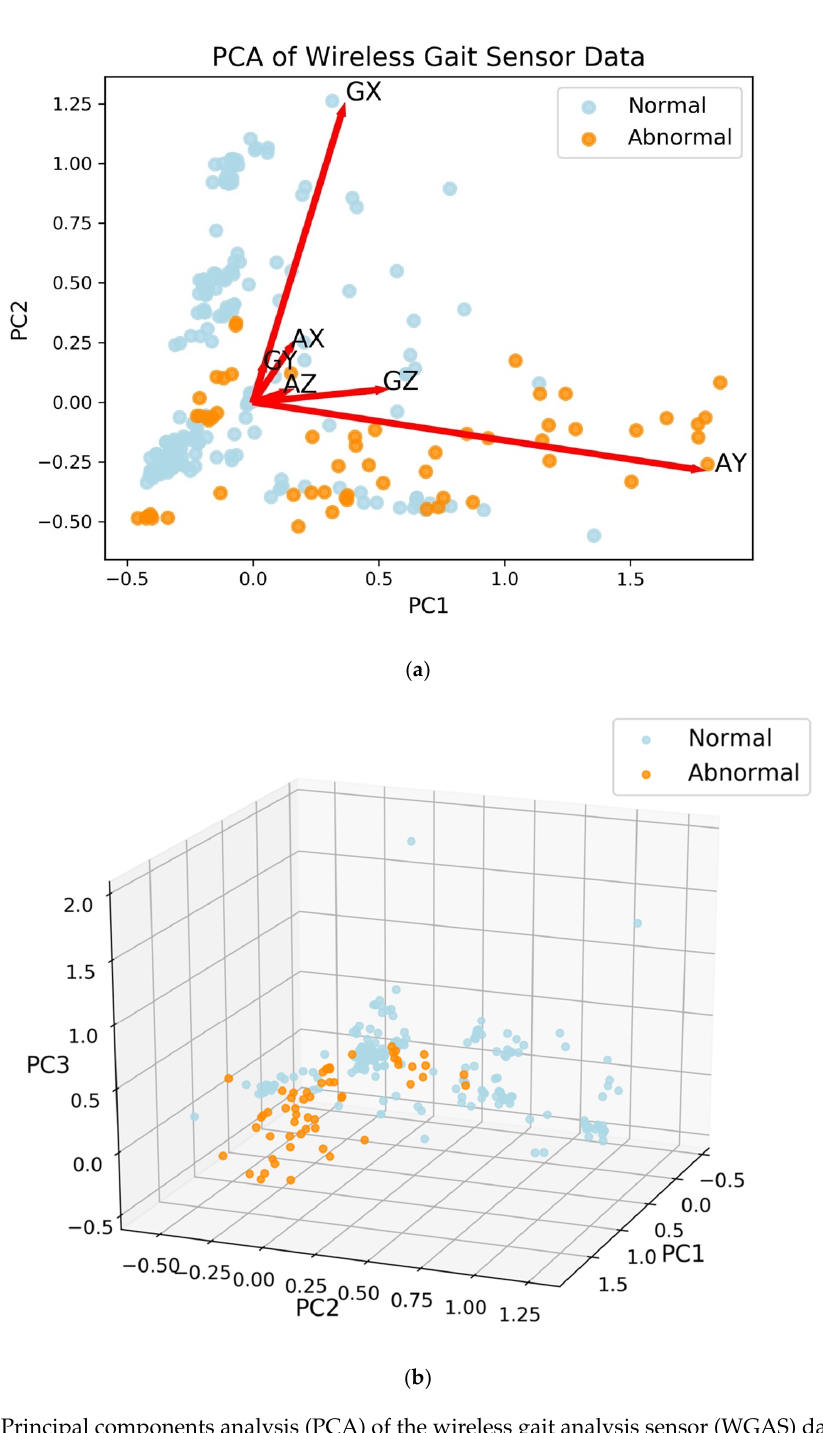
Figure 2. Principal components analysis (PCA) of the wireless gait analysis sensor (WGAS) data. Each point represents a pairing of subject with dynamic gait index test. ( a ) Projection with 2 principal components (PCs) shown with loadings. The first letter of the loading vector labels is for angular velocity from the gyroscope (G) or linear acceleration (A), while the second letter of the label denotes axis (X, Y, or Z). ( b ) With the first three PCs, the subjects with normal gaits are separated from those with abnormal